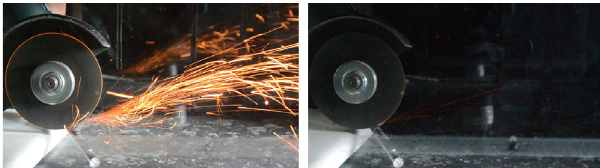
Fig. 8. Comparison of the sparks produced by grinding in a chamber fi lled with air (left) and with neon